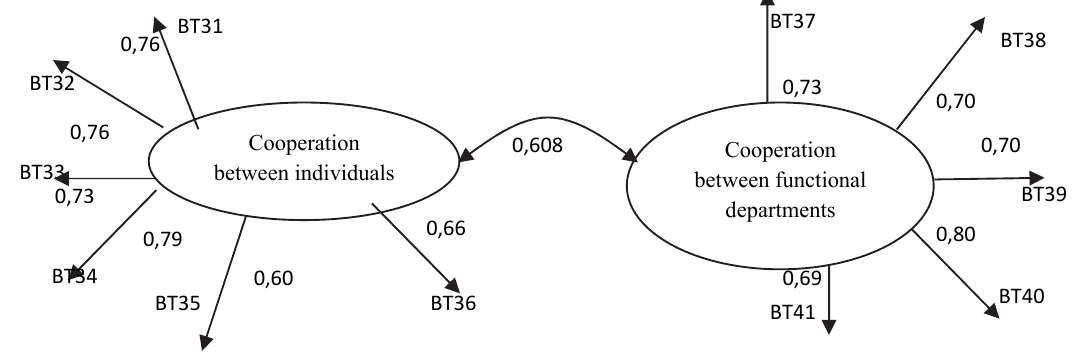
Fig. 1. CFA (standardized) scale of bank’ internal social capital